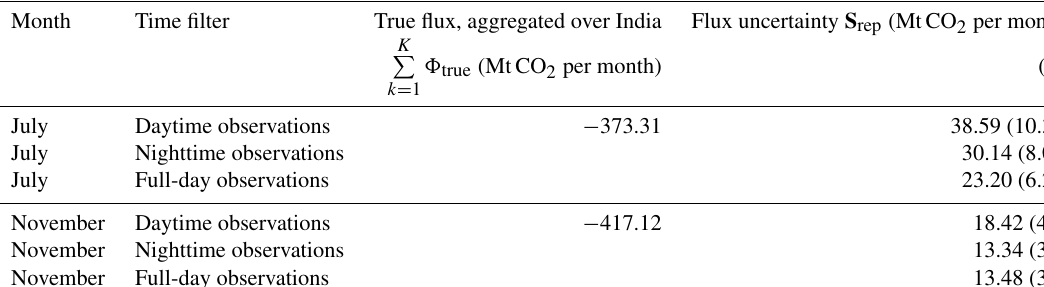
Table 3. Flux uncertainty over India calculated from the OSSE experiments using a pseudo-observation network of surface observations. The time filter indicates the time of the data sampled for estimation of the scaling factors. A full day is 24h in each day, daytime is from